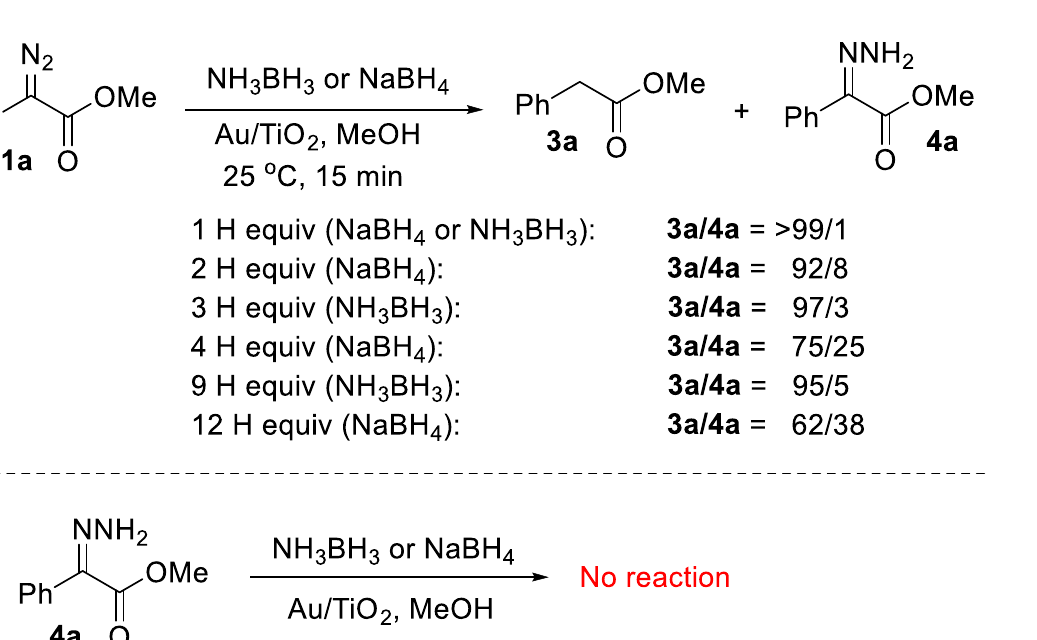
Figure 1. Reduction of α-diazocarbonyl compounds by NH 3 BH 3 or NaBH 4 catalyzed by Au/TiO 2 . a With one additional B- H equivalent, the corresponding alcohols of the ketones 3j – l were isolated in > 90% yield. b In this case, the corresponding hydrazone (Ε/Ζ = 85/15) was formed in 15% relative yield using NH 3 BH 3 and in 25% with NaBH 4 . The isolated yield refers to the reaction with NH 3 BH 3